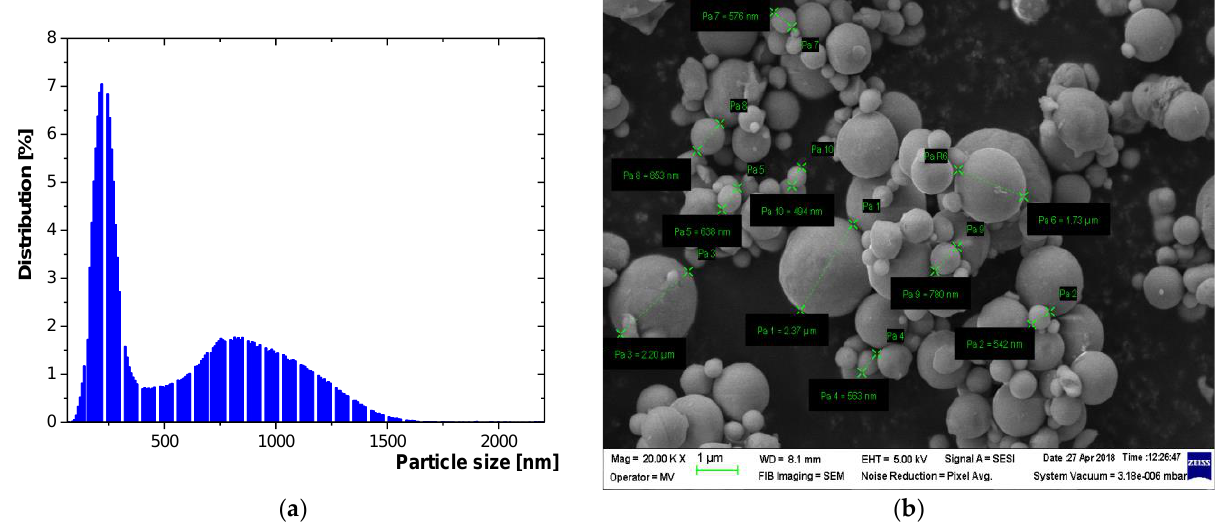
Figure 10. ( a ) Histogram — particle size distribution for Al/800 nm powder; ( b ) SEM image of Al/800 nm powder.